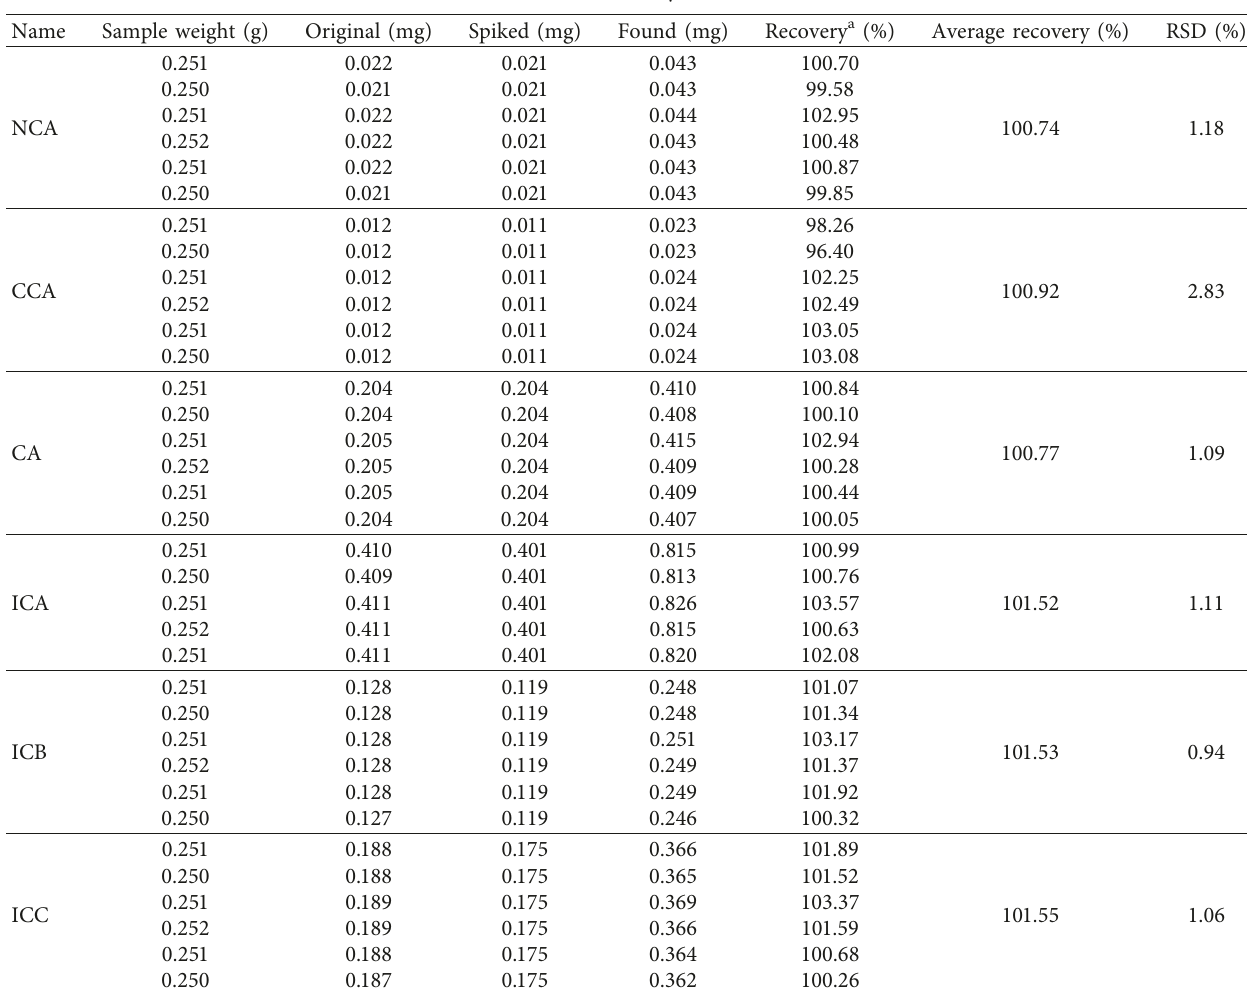
Table 4: Recoveries of six CAs as determined by the standard addition method ( n �